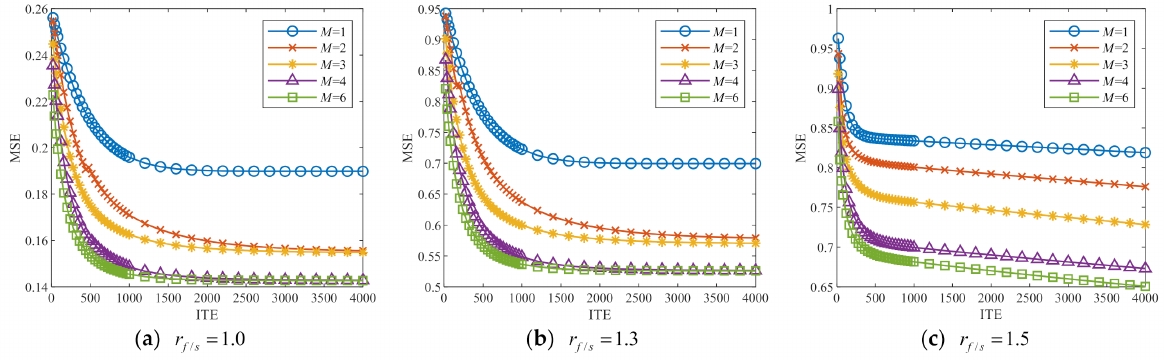
Figure 4. MSE of M -piecewise extrapolation for the signal f = sinc ( t ) , ( − 4 < t < 4 ) at α =